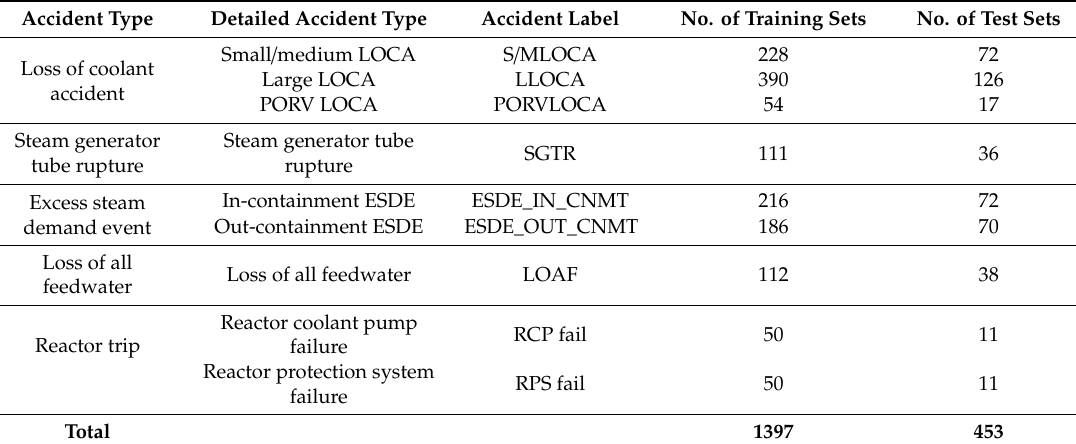
Table 1. Number of training and test sets for the nine simulated